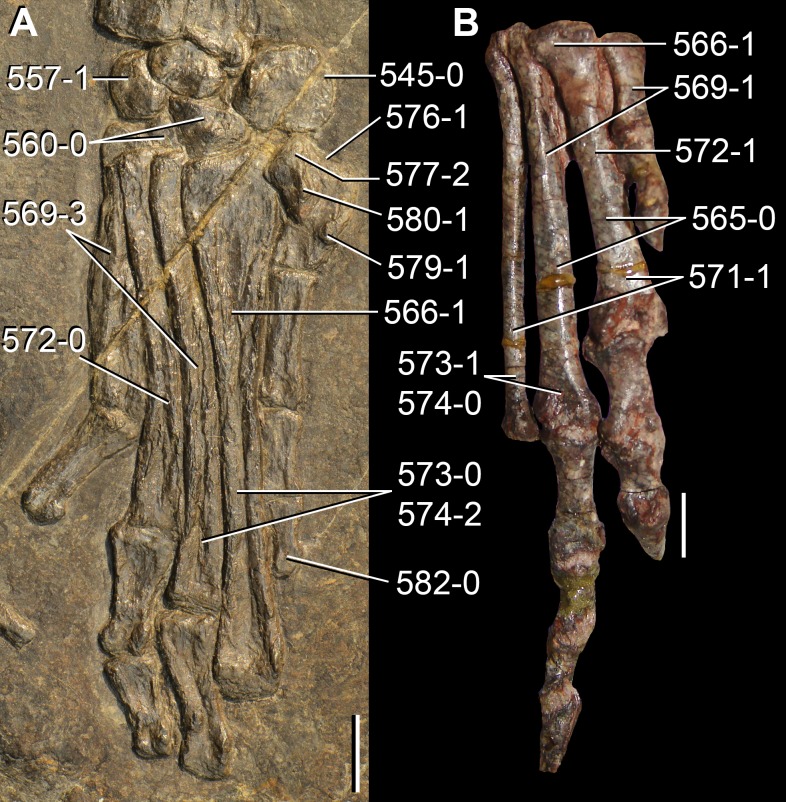
Right posterior autopodia of Triassic archosauromorphs in (A) posterior/ventral and (B) anterior/dorsal views.(A) Macrocnemus bassanii (PIMUZ T2472); and (B) Tropidosuchus romeri (PVL 4601). Numbers indicate character-states scored in the data matrix. Scale bars equal 5 mm.